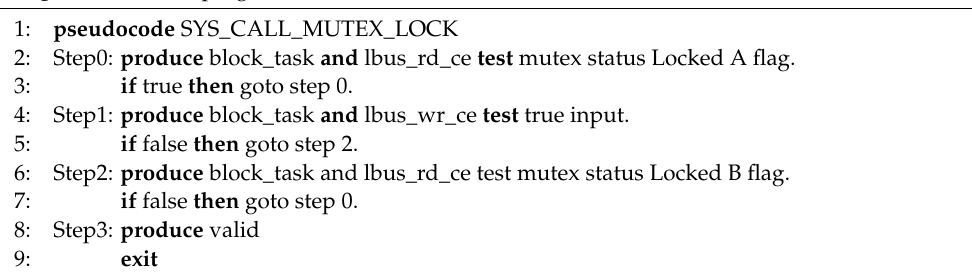
Algorithm 1 Microprogram to lock a Hardware